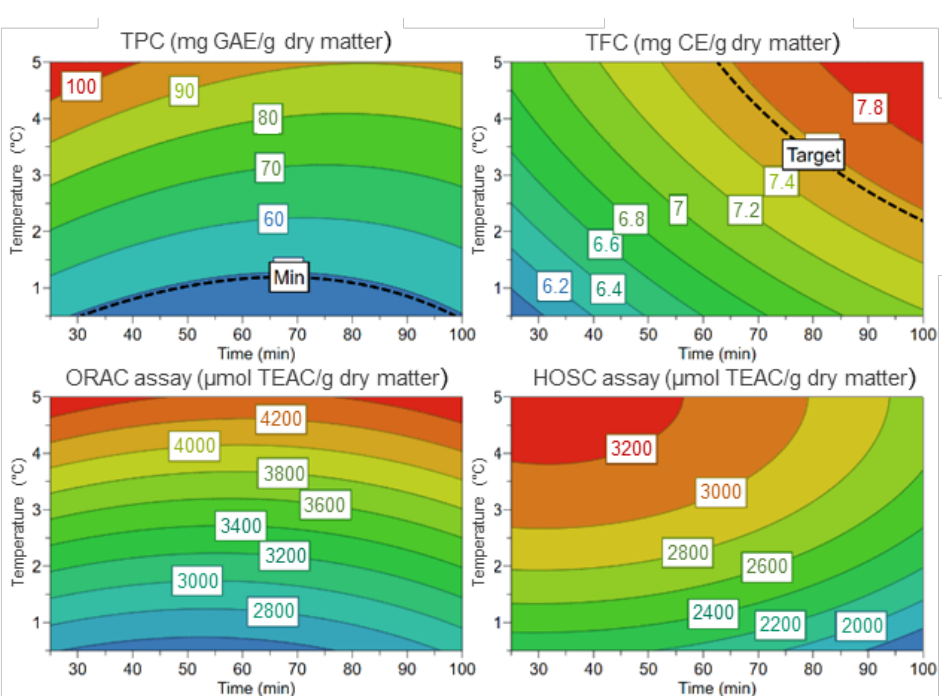
Figure 3. Response contour plots representing the effects of time and temperature at a constant ethanol concentration (100%), on all extraction responses. Lower values are represented in blue and higher values in red.